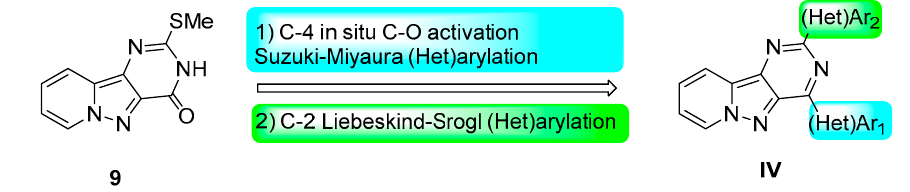
Figure 2. Bis(het)arylation of 9 leading to targeted structure IV .